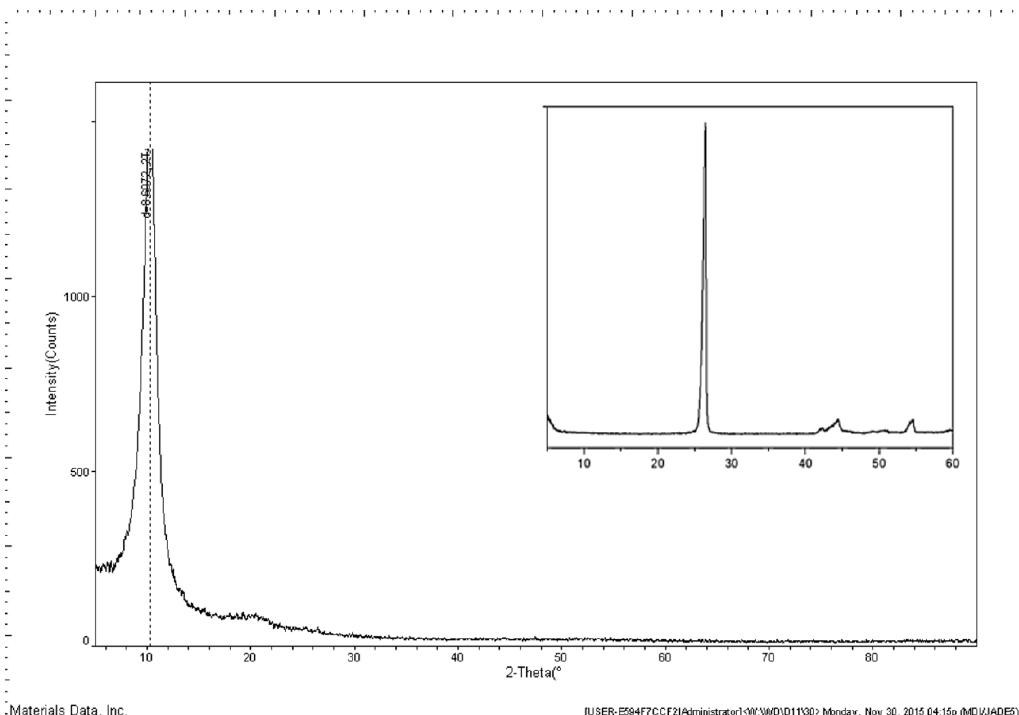
Figure 8. XRD photo of the GO sensing material.